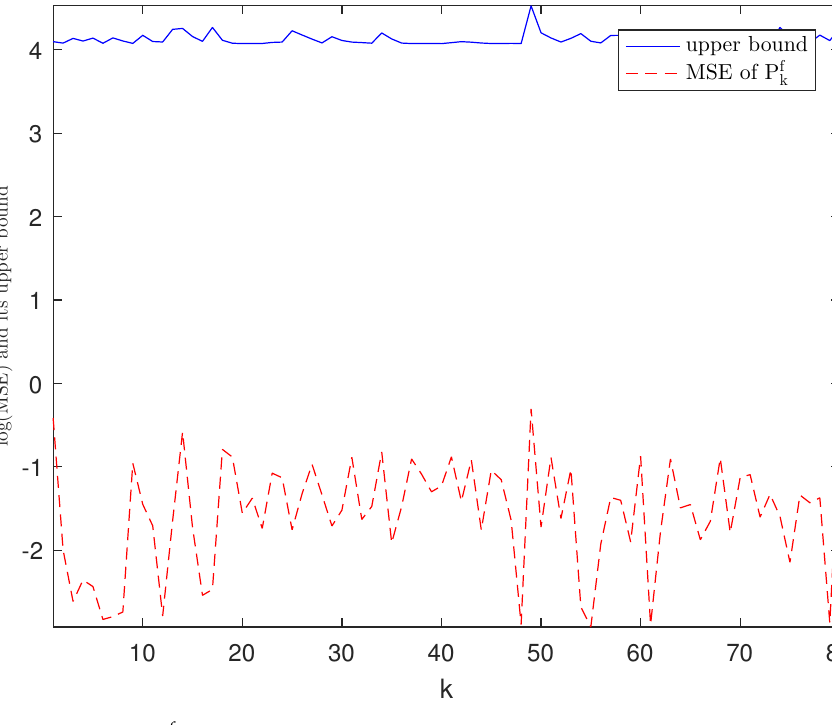
) of x 1 , x 2 and the traces of their upper bounds. k k k